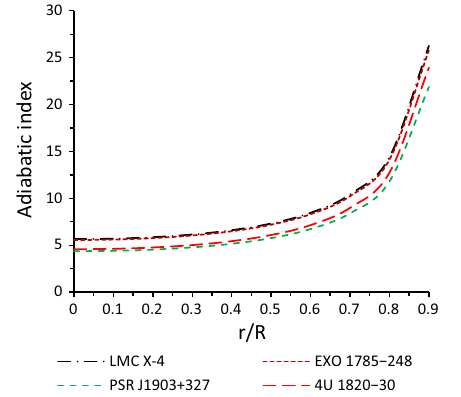
Fig. 10 Behaviour of adiabatic index (cid:2) r vs. fractional radius r / R for LMC X-4, EXO 1785-248, PSR J1903+327 and 4U 1820-30. For plot- ting this figure we have employed data set values of physical parameters and constants which are the same as used in Figs. 8 and